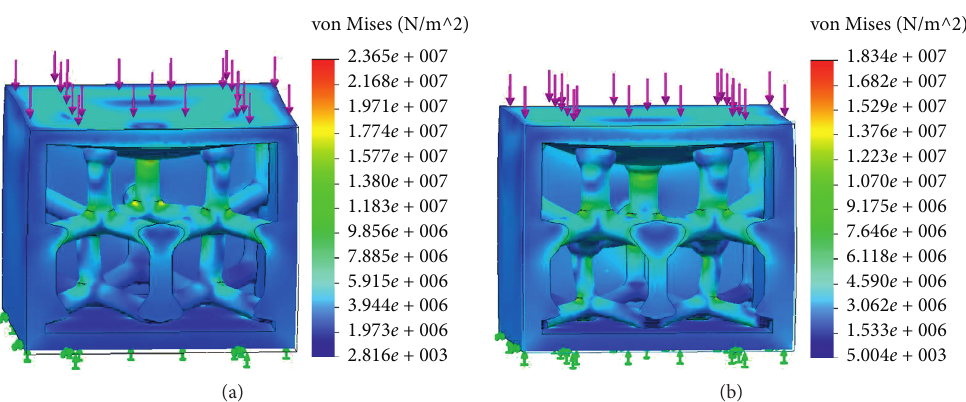
Figure 12: Comparison of stress state. (a) The superposition of constant density units ( r � 1mm). (b) The superposition of variable density units ( r � 1.2 mm and 0.8